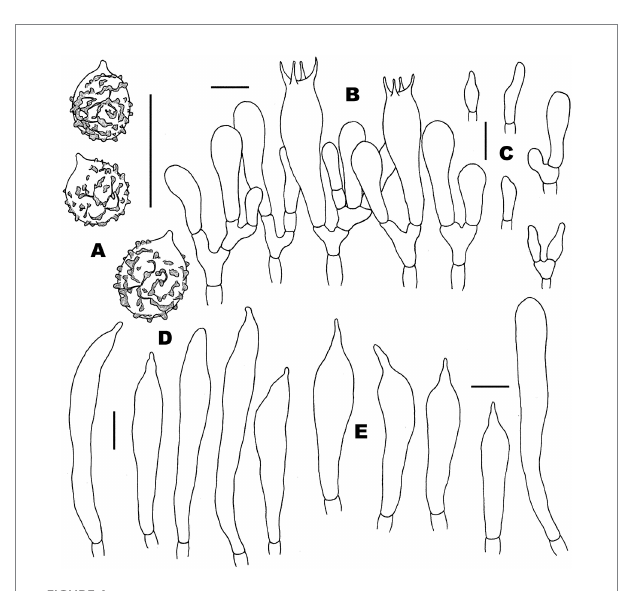
FIGURE 4 Microscopic features of Russula discoidea (FHMU4847, holotype). (A) Basidiospores. (B) Basidia and basidiola. (C) Marginal cells. (D) Pleurocystidia. (E) Cheilocystidia. Scale bars = 10 μ m. Drawings by Y. X. Han.